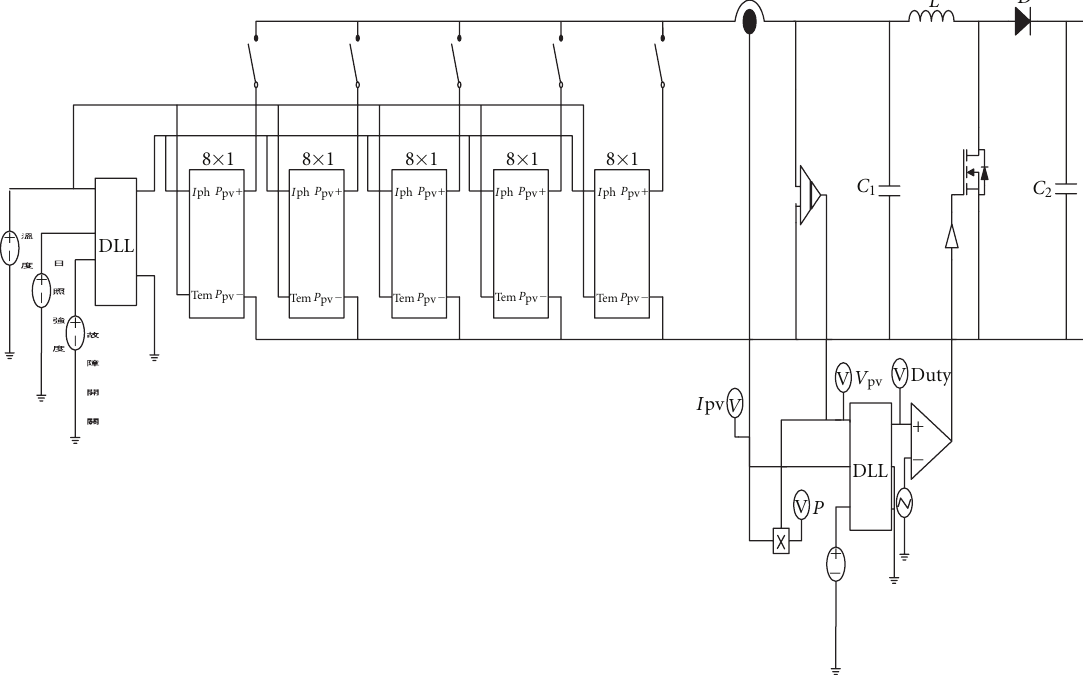
Figure 6: The solar power system by PSIM simulation software.